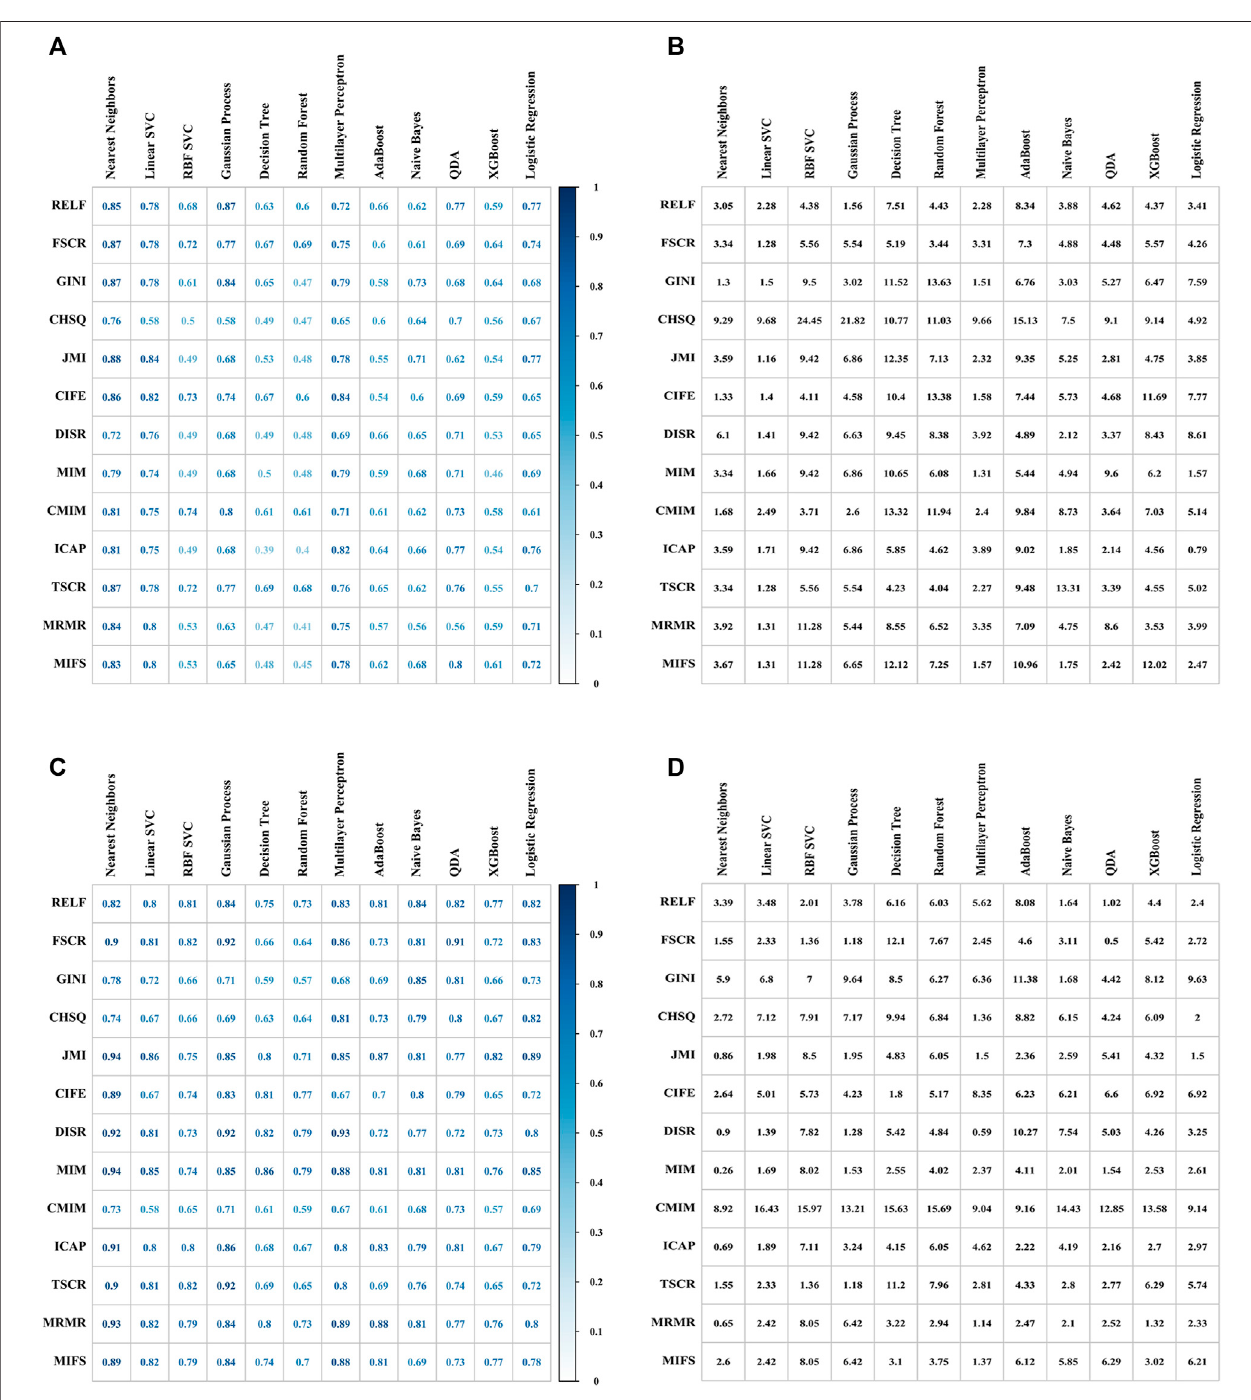
FIGURE3| Performanceofdifferentcombinationsoffeature selectors(rows)and MLclassi fi ers(columns)forpredicting short-term diseasecontrol.10-fold cross- validated AUC values (A) and RSD values (B) of 156 models with Radiomics features. 10-fold cross-validated AUC values (C) and RSD values (D) of 156 models with deep learning features extracted from